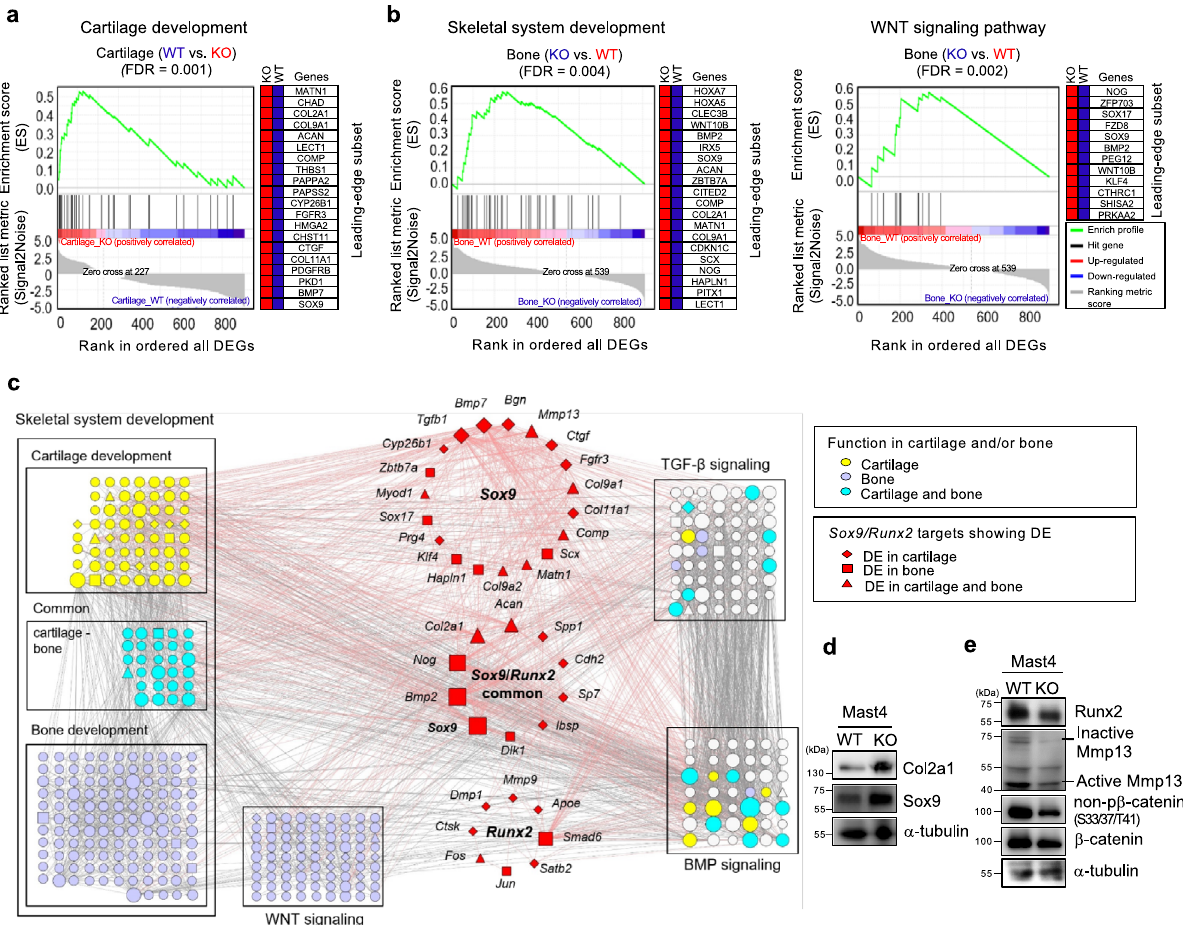
Fig. 6 Identi fi cation of the genes regulated by Mast4 in mouse cartilage and bone. a , b RNA sequencing was conducted by collecting and combining RNAs obtained from cartilage and bone of the tibias of Mast4 + / + and Mast4 − / − mice at PN 1 day (3 mice per each group). a The enrichment of upregulated genes associated with cartilage development in the cartilage of Mast4 − / − mice. Twenty up-regulated genes were predicted as the leading- edge subset of the enriched gene set. b The enrichment of upregulated genes associated with skeletal system development and Wnt signaling pathway in the bone of Mast4 + / + mice. In the plot, 20 and 12 genes were upregulated as the leading-edge subsets of the enriched gene sets in Mast4 + / + mice. Gene set enrichment analysis was applied with a background dataset consisting of all DEGs analyzed from cartilage and bone of the tibias of Mast4 + / + and Mast4 − / − mice. c Mast4-regulated transcriptional network of Sox9 and Runx2 targets showing differential expression in cartilage and bone. The Sox9 and Runx2 targets are linked to the genes related to the functions of skeletal system development, including cartilage and bone development, TGF- β signaling, BMP signaling and Wnt signaling. d Western blot analysis of Col2a1 and Sox9 proteins in the cartilage tissues of Mast4 + / + and Mast4 − / − mice at PN 1 day. e Western blot analysis of Runx2, Mmp13 and β -catenin proteins in the bone tissues of Mast4 + / + and Mast4 − / − mice at PN 1 day. d , e The representative results were obtained from at least three independent experiments. Uncropped blots in d , e are shown in Source Data fi